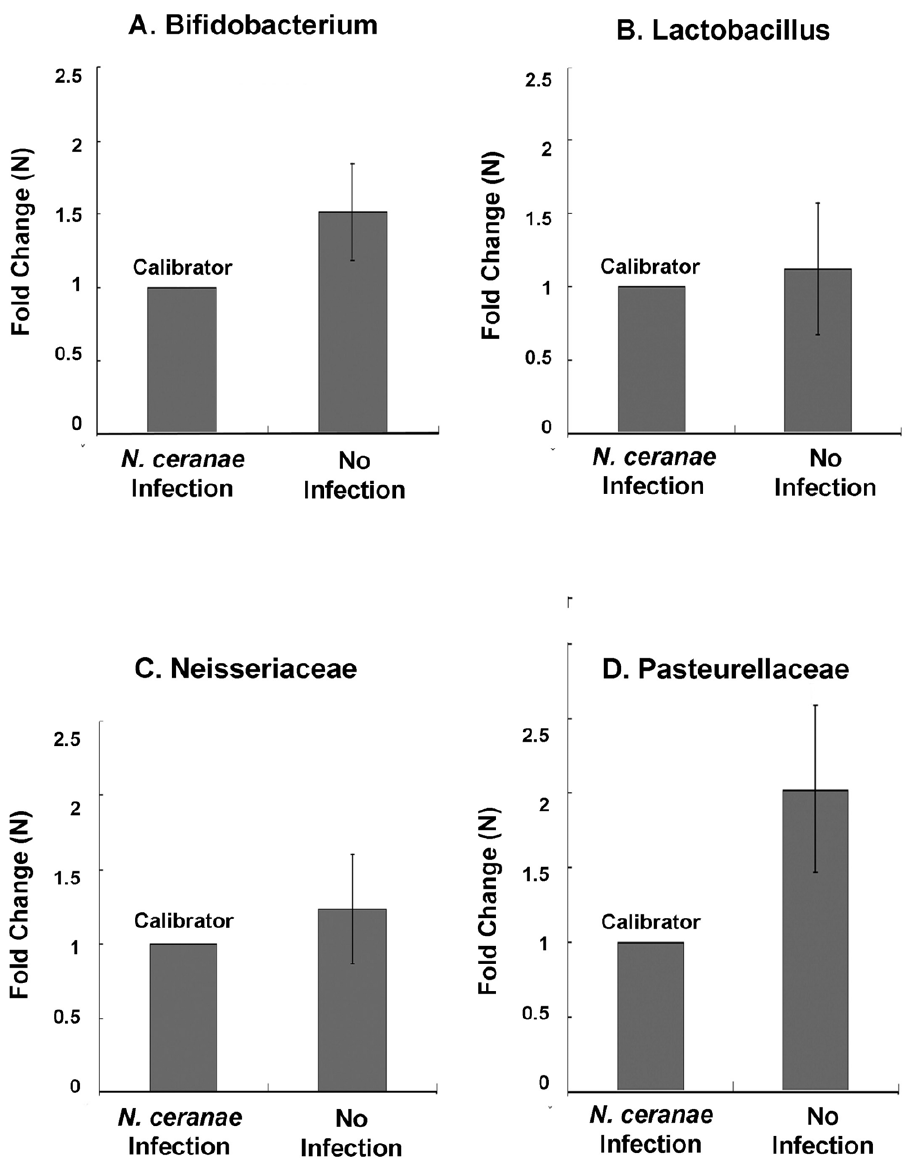
Figure 7. Relative abundance of four bacterial groups between N.ceranae -infected and non-infected A.cerana . A) Bifidobacterium; B) Lactobacillus, C) Neisseriaceae, and D) Pasteurellaceae. The y-axis depicts fold difference in quantities of each bacterial species between non-infected workers and N. ceranae infected workers. For each bacterial group, the N. ceranae infected workers had relatively lower level of bacterial titer, compared to non-infected bees and therefore was chosen as a calibrator. The concentration of each bacterial group in non-infected bees was compared with calibrator and expressed as n-fold change.